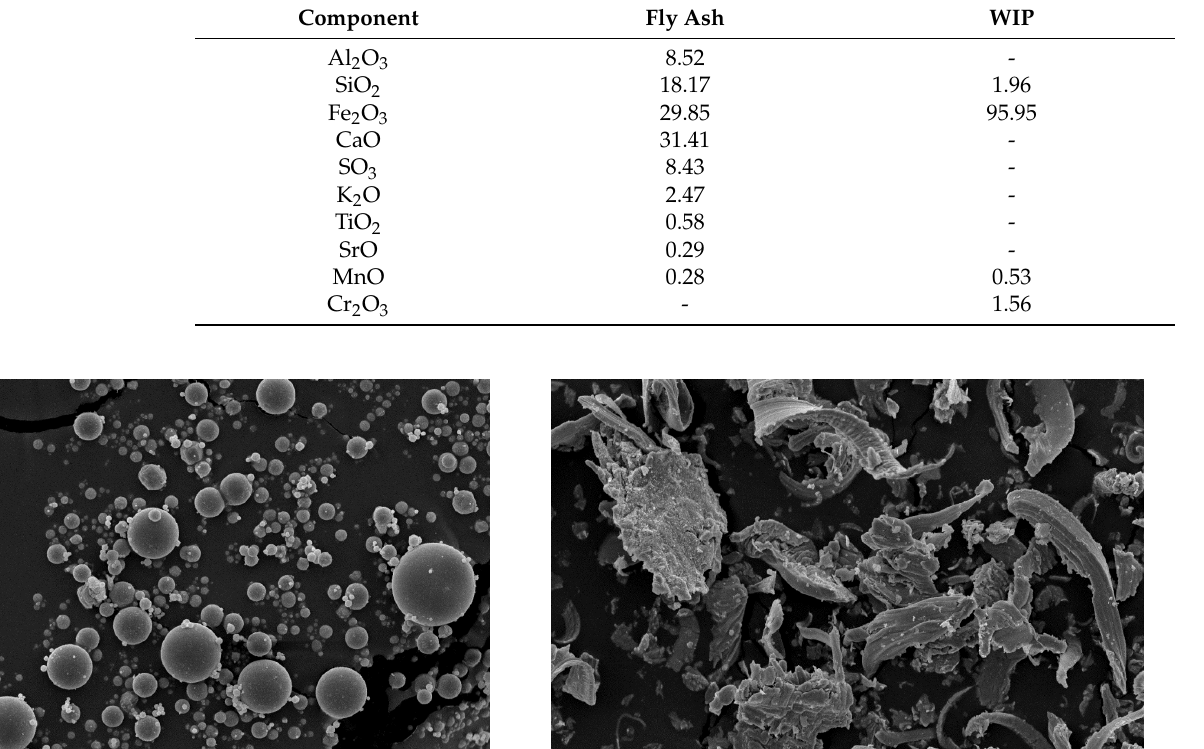
Table 1. Oxide compositions of Mae Moh fly ash and WIP.